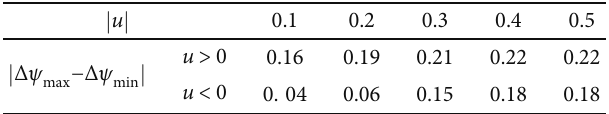
Figure 15: Teeth pressure loads in the critical state ( Re = 10000 , π = 4 , M Table 4: Maximum deviation of di ff erent teeth pressure loads in the critical state ( Re = 10000 , π = 4 , M U = 0 : 23 , and C = 0 : 067 ). u j